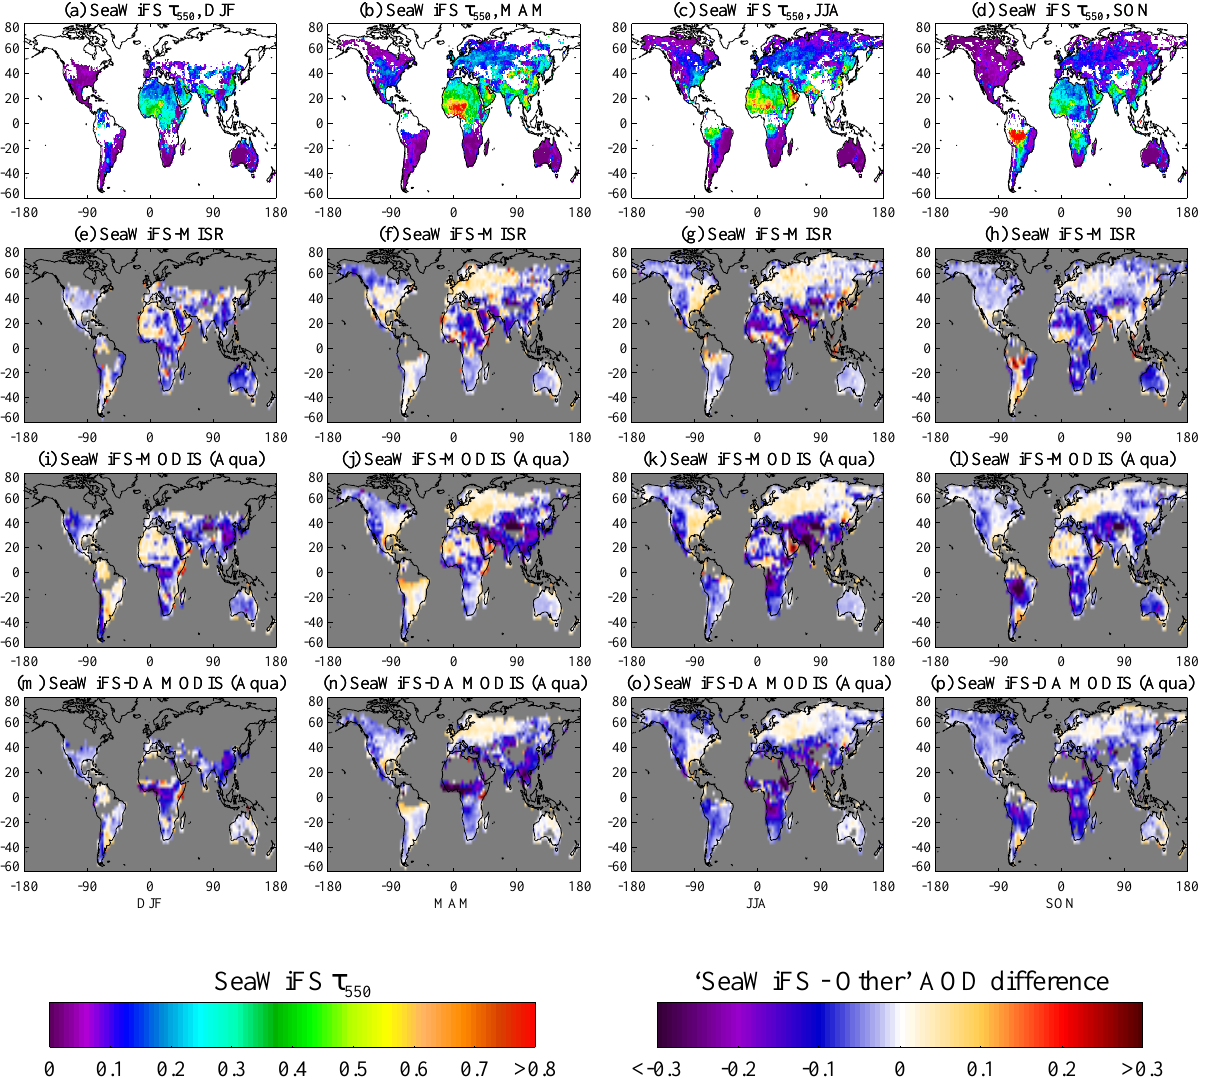
Fig. 8. Comparison between seasonal mean colocated SeaWiFS AOD at 550nm and other satellite datasets. From left to right, columns indi- cate the seasons December-January-February (DJF), March-April-May (MAM), June-July-August (JJA), and September-October-November (SON). The top row shows (a–d) SeaWiFS seasonal mean AOD. Successive rows show the difference in seasonal mean AOD from colocated data between SeaWiFS and (e–h) MISR; (i–l) MODIS (Aqua); and (m–p) DA-MODIS (Aqua).